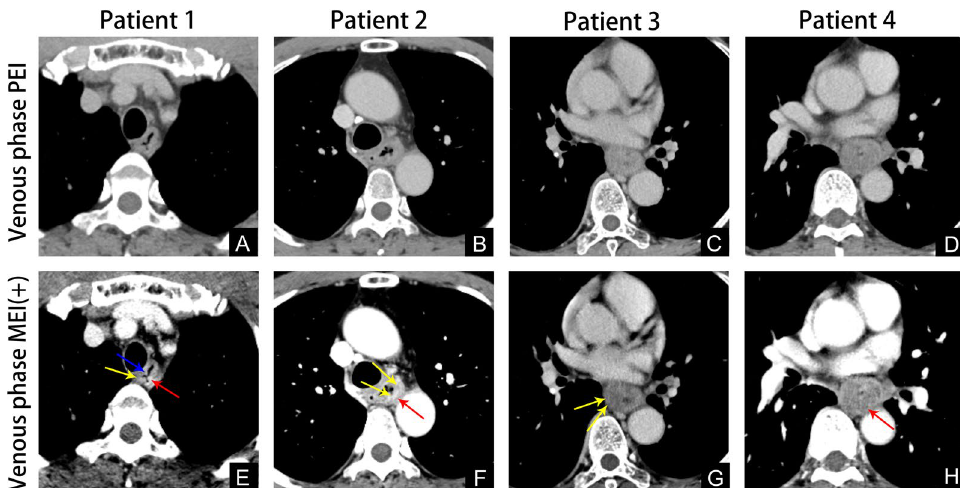
Fig. 5 A and E , 66-year-old man with esophageal cancer, venous phase PEI image A , venous phase MEI ( cannot distinguish the tumor, MEI ( ) 40 keV shows the high-density muscularis mucosae (blue arrow) and muscularis propria (yellow arrow) are + interrupted, and the lesion (Red arrow) is staged as T1b. B and F , 64-year-old man with esophageal cancer, venous phase PEI image B , venous phase MEI ( ) 40 keV image F , PEI image CT cannot distinguish the boundary of tumor, MEI ( + propria (yellow arrow) and the boundary of lesion is clear (Red arrow). The lesion is staged as T2. C and G , 69-year-old man with esophageal